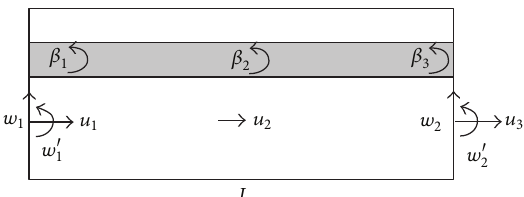
Figure 3: Nodal degrees of freedom for a finite